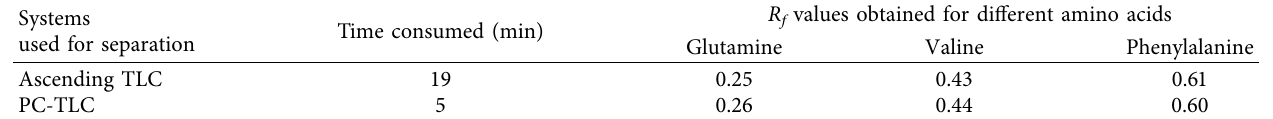
Table 1: Separation of amino acids by classical and pressurized TLC.